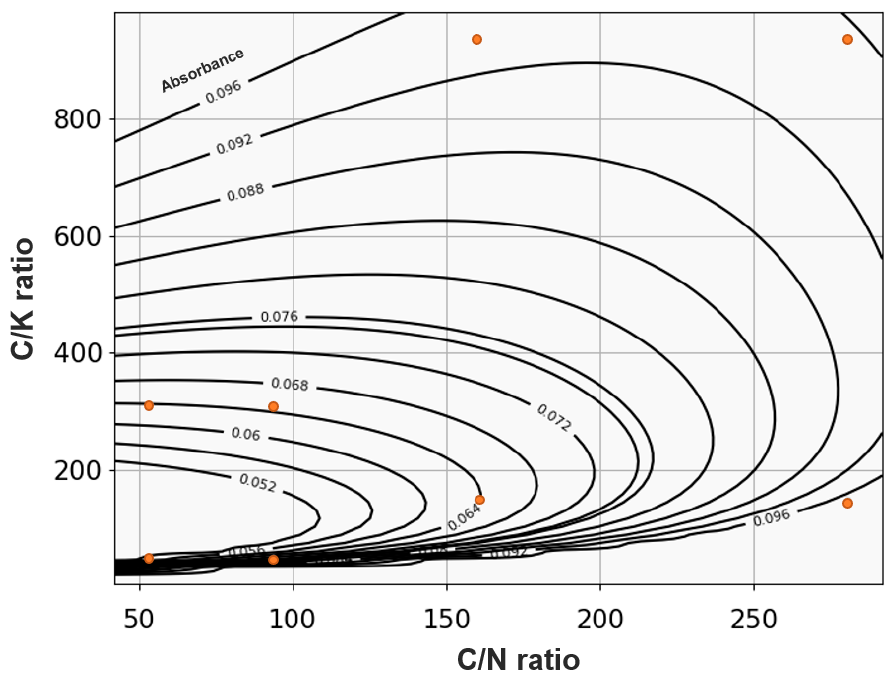
Figure 7. Contour lines of the response surface of the mathematical model of absorbance as a function of the C/N and C/K ratios.